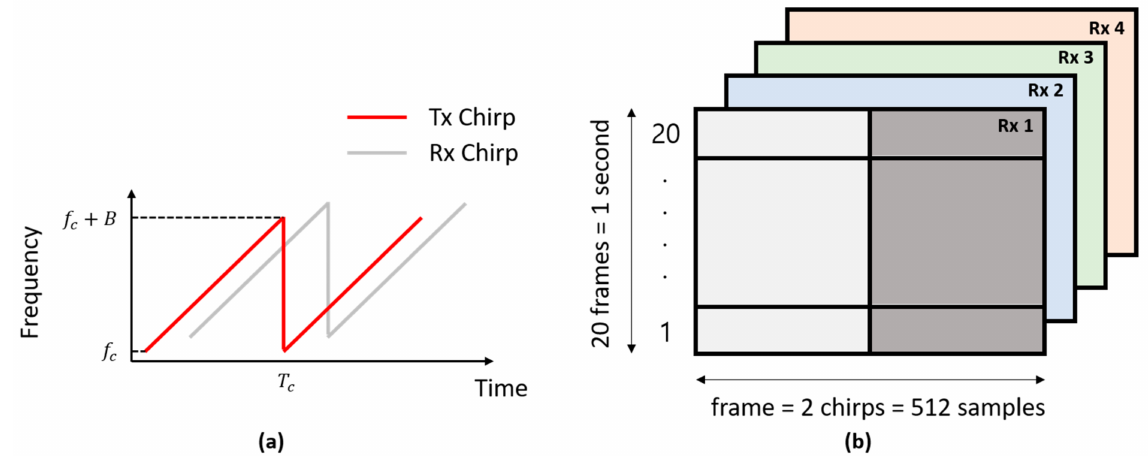
Figure 2. ( a ) The transmitted and received chirps and ( b ) the received radar data signals for all the four receivers, denoted as Rx 1, Rx 2, Rx 3, and Rx